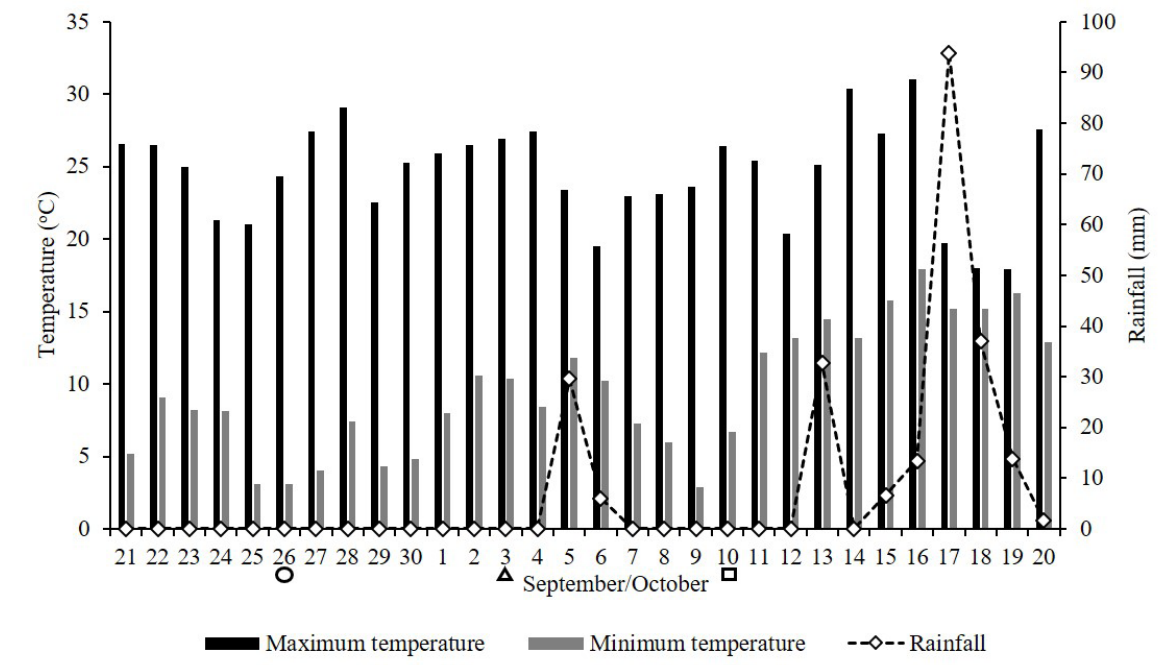
Figure 2. Climatic conditions before and following treatments application in September and October 2016/2017 growing season in Antônio Prado, RS. Application dates are indicated by circle (full bloom), triangle (7 days after full bloom – DAFB) and a square (14 DAFB) bellow the “x” axis. Source: FieldClimate - Antônio Prado Weather Station (Antônio Prado,